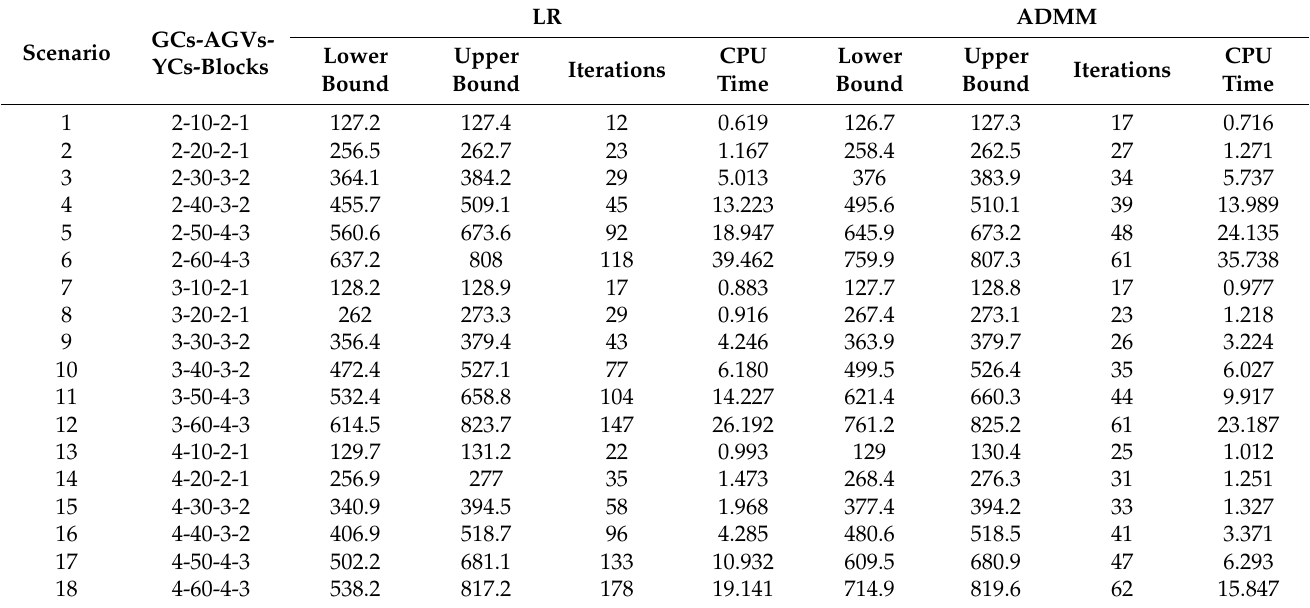
Table 4. Comparison of experimental data of LR and